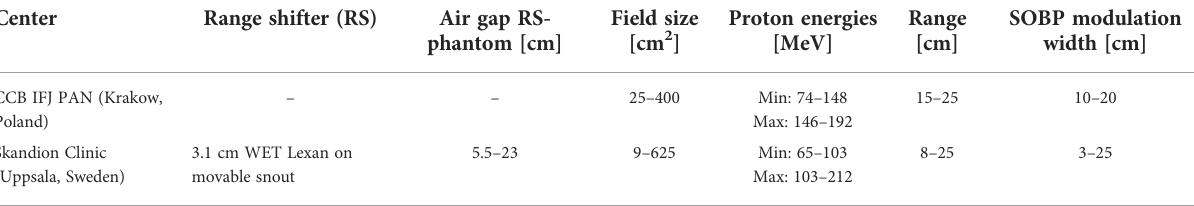
TABLE 1 Overview of covered treatment plans during the measurement campaigns at the CCB IFJ PAN and Skandion proton therapy facilities with PBS. Center Range shifter (RS) Air gap